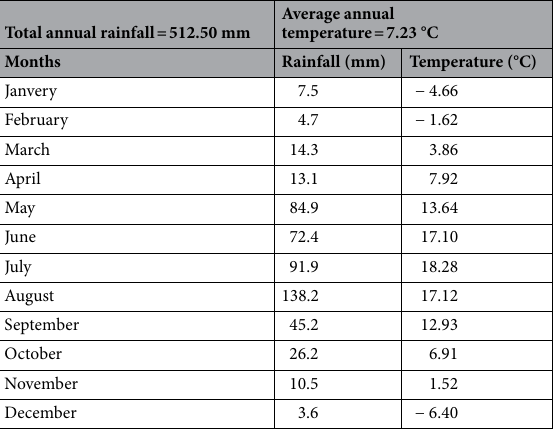
Total annual rainfall = 512.50 mm